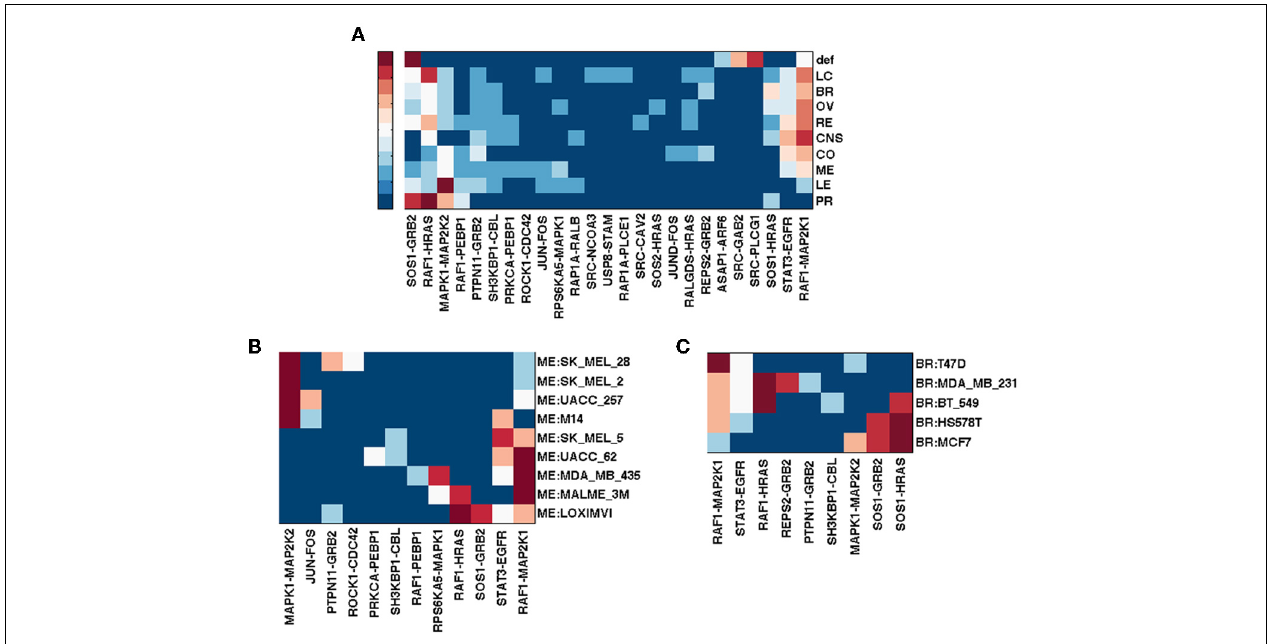
(A) Edge ranking by e r b for tumor types. (B) Edge ranking by e r b for b NCI60 melanoma cell lines. (C) Edge ranking by e r b for NCI60 breast cancer cell